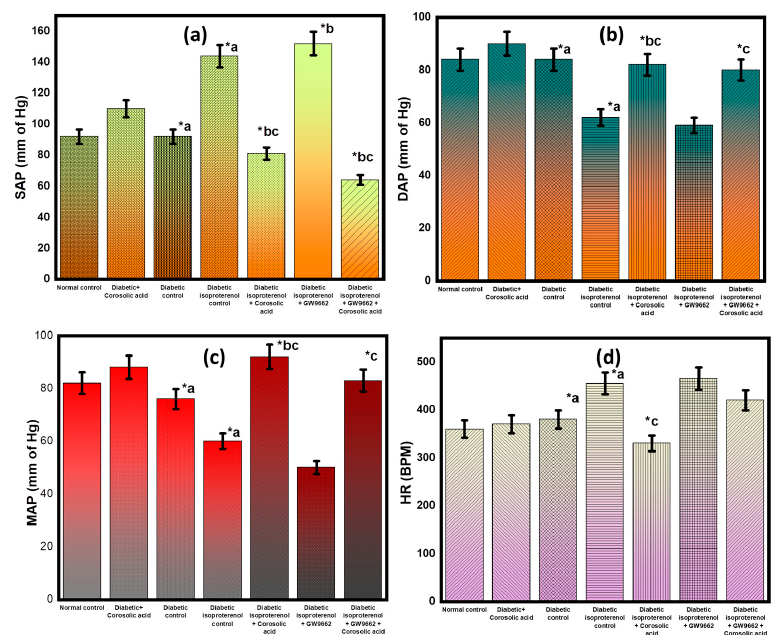
Figure 3. Effects of corosolic acid on heart rate and hemodynamic parameters in different groups: ( a ) SAP; ( b ) DAP; ( c ) MAP; ( d ) HR. The data are expressed in the form of mean ± standard error average (SEM). The significance was determined by one-way ANOVA followed by the Bonferroni’s post hoc test: * p ≤ 0.05 is considered significant. a normal control vs. diabetic control and diabetic isoproterenol control; b diabetic control vs. corosolic acid and GW9662 treatments; and c diabetic isoproterenol control vs. corosolic acid and GW9662 treatments. (SAP: systolic arterial pressure; DAP: diastolic arterial pressure; MAP: mean arterial pressure; HR: heart rate).